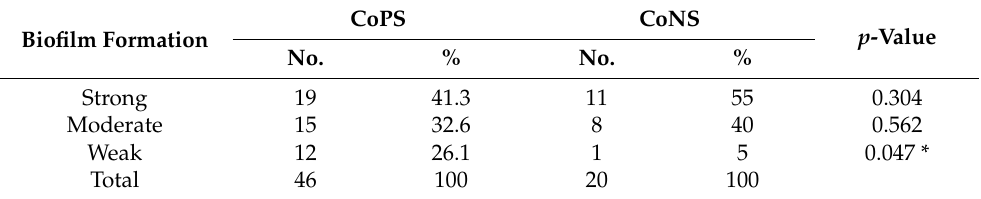
Table 3. Biofilm formation, estimated via microtiter tissue culture plates, amongst 66 bacterial isolates collected from patients and classified into 46 CoPS and 20 CoNS isolates.